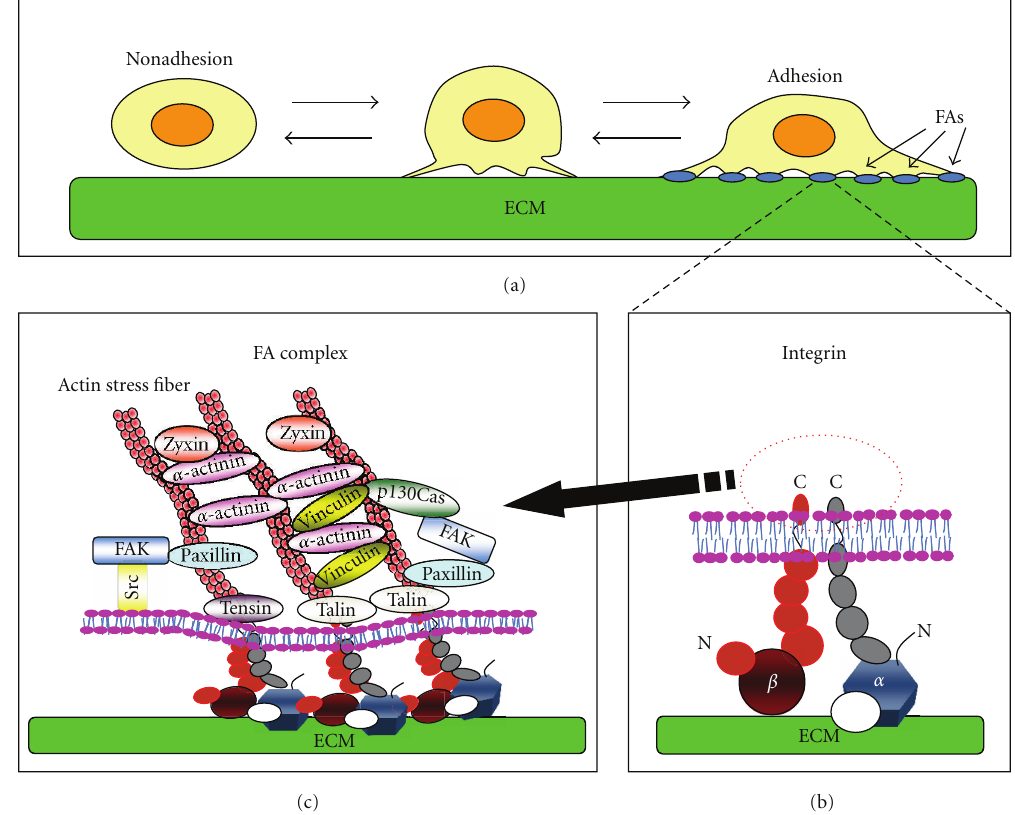
Figure 1: Integrin-mediated cell adhesion to the ECM. (a) Suspended cells adhere to the surface of ECM via integrins. Some of the nascent adhesion contacts grow and form mature focal adhesions (FAs). (b) Integrins function as a heterodimer composed of α - and β -chains. (c) The cytoplasmic portions of integrins recruit multiple cellular proteins and form cross-linked platforms to regulate both the actin cytoskeleton and signal